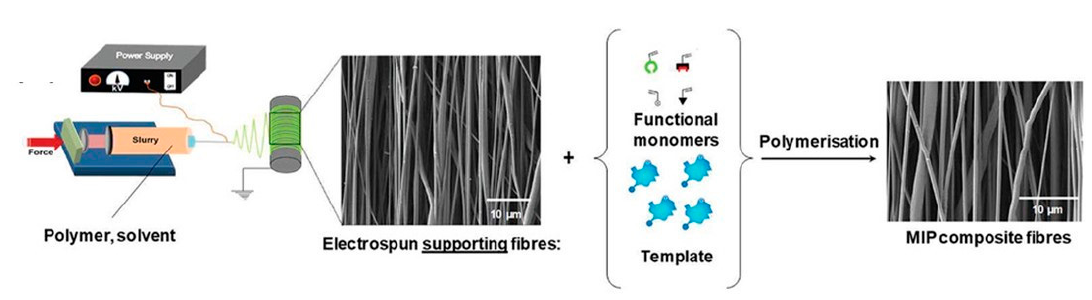
Figure 6. Schematic illustration of electrospinning set-up, production of fibers, and a MIP layer on the surface of fibrous membranes. In this example, a MIP layer is made onto the surface of electrospun supporting fibers. Reproduced with permission from [28].